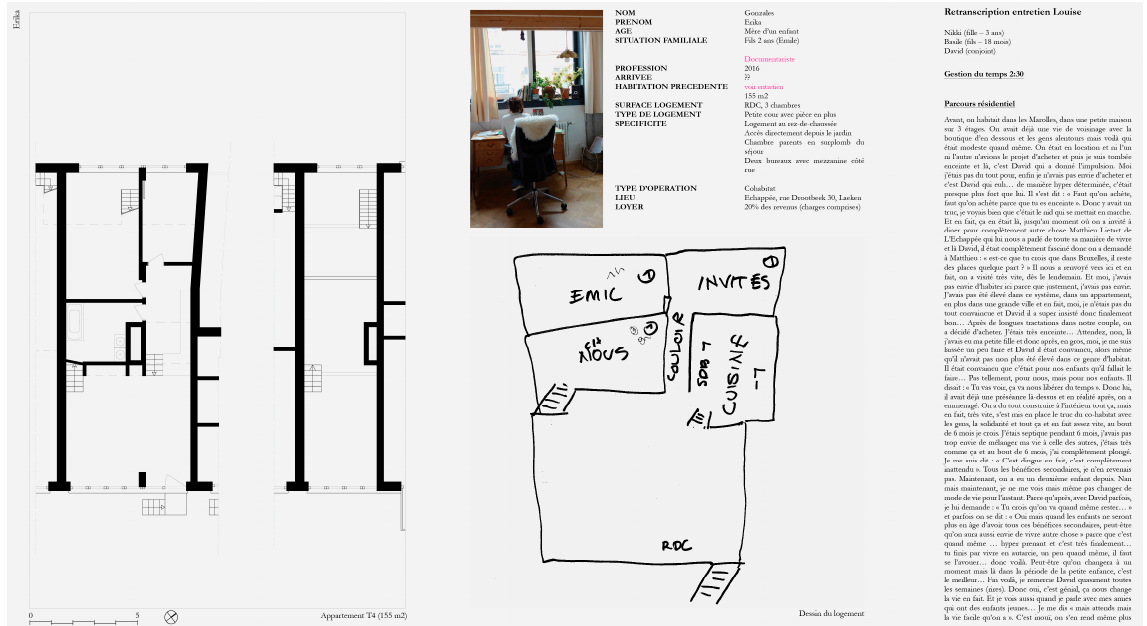
Figure 2. Catalogue sample.